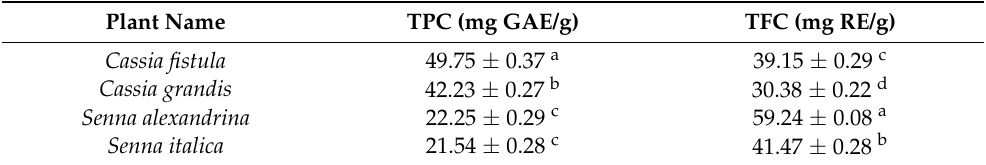
Table 1. Total polyphenolic and flavonoid contents of leaf methanolic extracts of the Cassia and Senna species. Plant